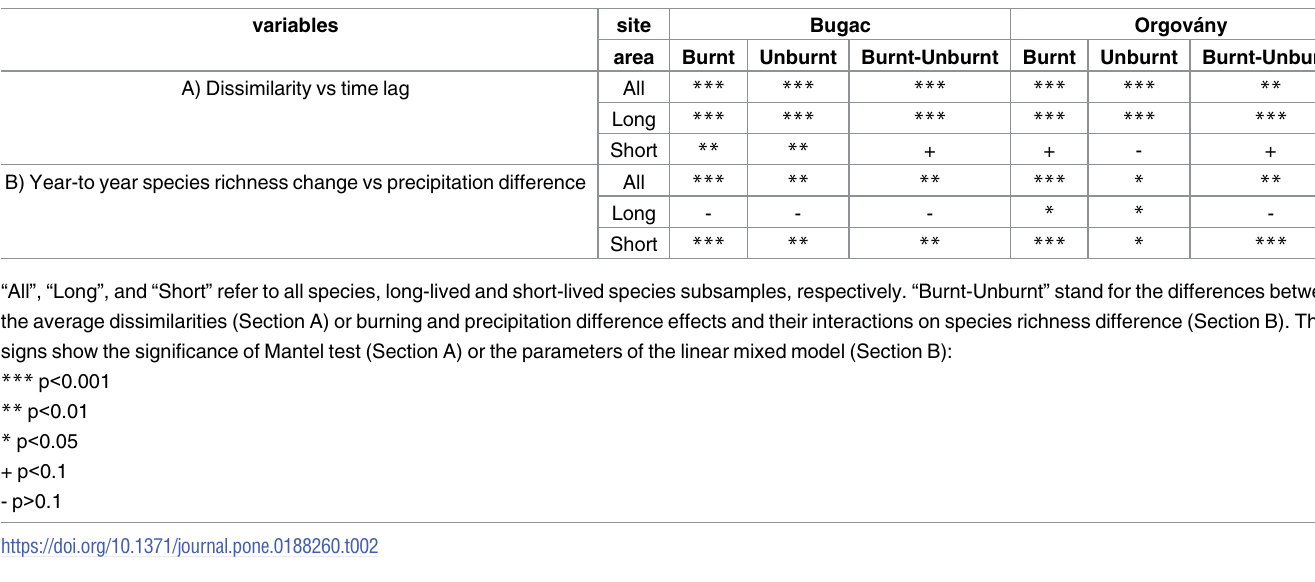
Table 2. Summaryof statistical